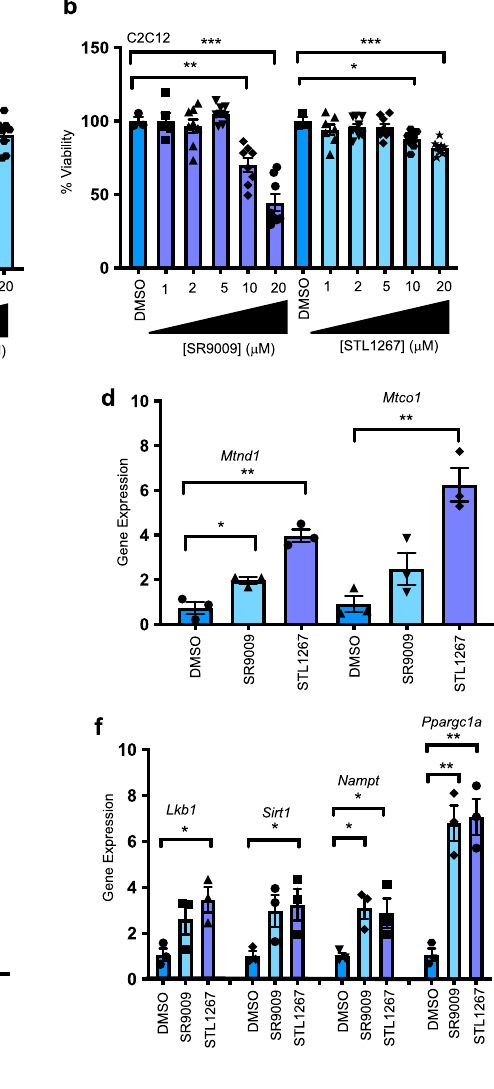
Fig. 2 | STL1267 regulates REV-ERB target genes in cell-based assays. a HepG2 cells treated with DMSO (blue), SR9009 (purple) or STL1267 (light blue) for 24h ( n =3 to 8) followed by assessment of cell viability by crystal violet staining. DMSO vs. 10 μ M SR9009. b Proliferating C2C12 cells treated with DMSO (blue) SR9009 (purple) or STL1267 (light blue) for 24h ( n =3 to 8) followed by assess- ment of cell viability by crystal violet staining. (DMSO vs. 10 μ M SR9009 P =0.0003; DMSO vs. 20 μ M SR9009 P <.0001; DMSO vs. 20 μ M STL1267 P =0.0481). c Expression of BMAL1 in HepG2 cells in response to 24h treatment with DMSO (blue), 5 μ M STL1267 (purple) or SR9009 (light blue) ( n =4) P =0.0010 vehicle vs. STL1267, P =0.0009 vehicle vs. SR9009. Relative gene expressionin C2C12 cells ( n =3) in response to REV-ERB agonist treatment (5 μ M)